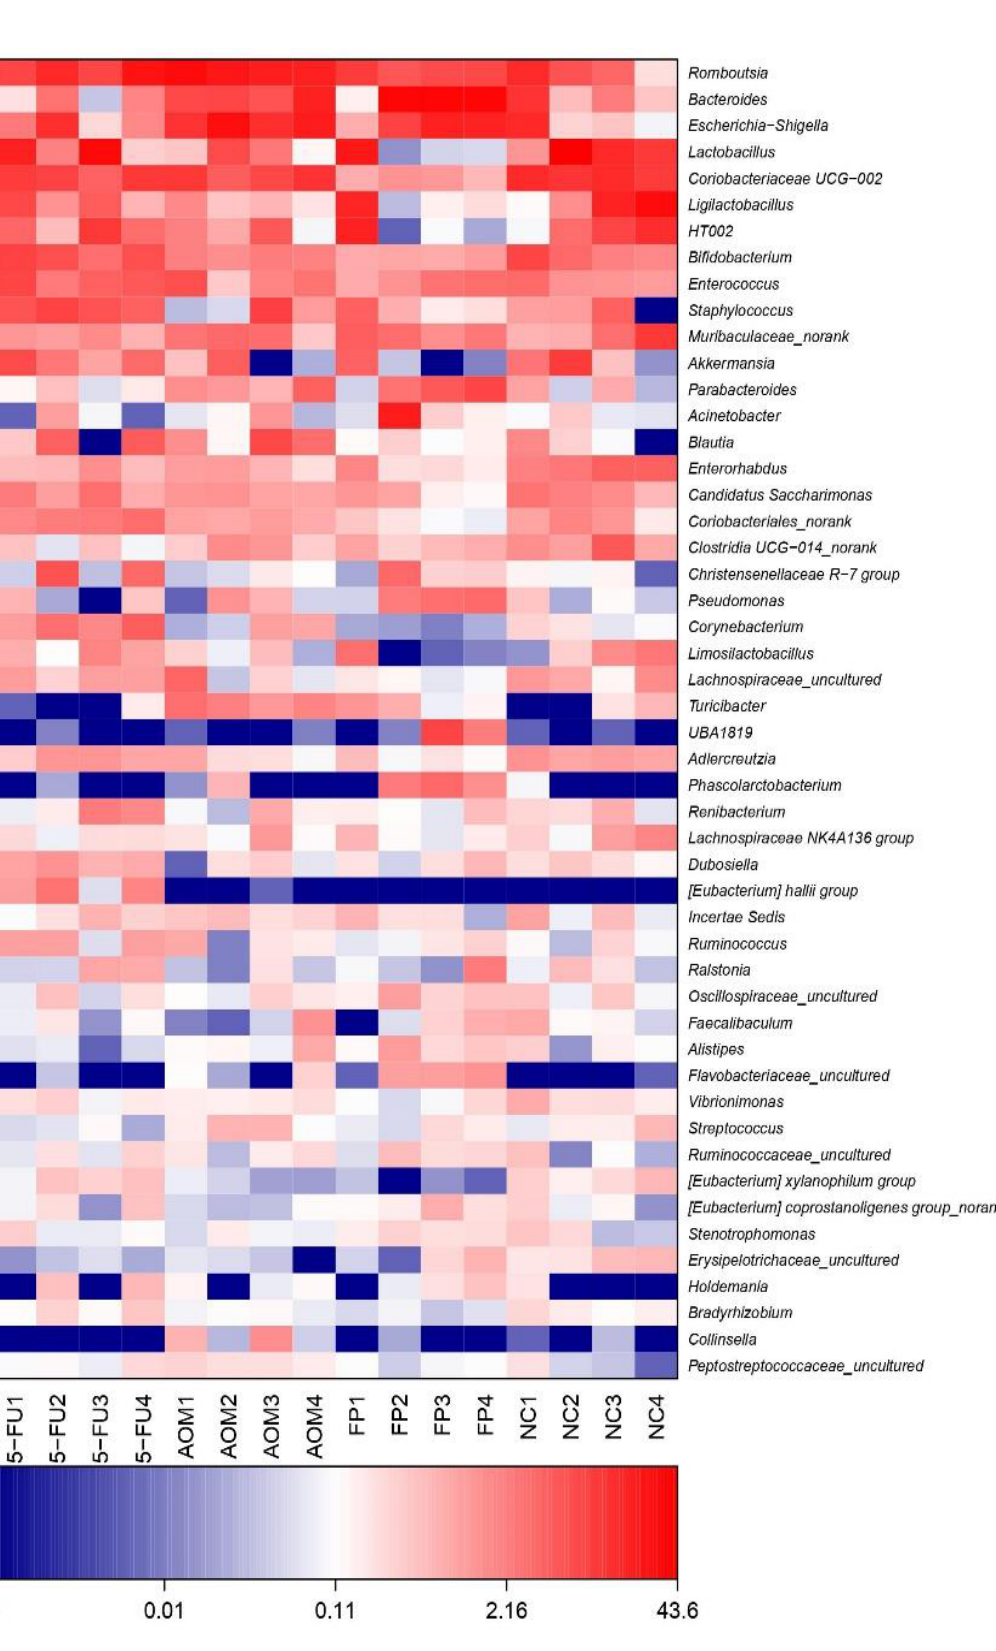
Figure 6. Heatmap of microbial diversity analysis at the genus level. (NC): Normal control group, (AOM): azoxymethane control group, (FP): F. prausnitzii group, (5FU): 5-fluorouracil reference group.